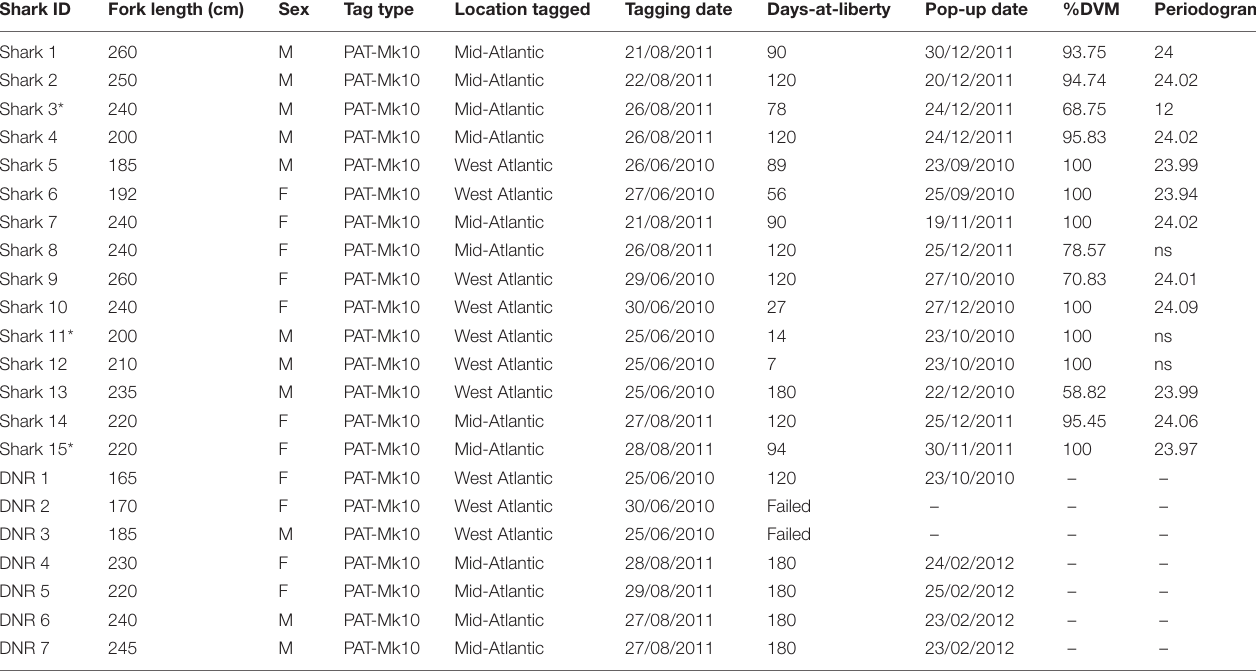
TABLE 1 | Summary data for satellite-tagged blue sharks. Shark